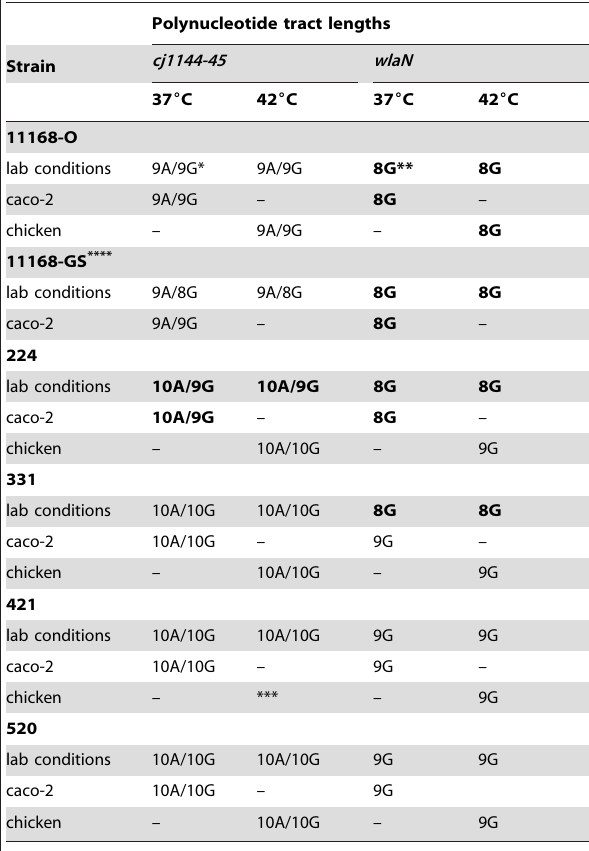
Polynucleotide tract